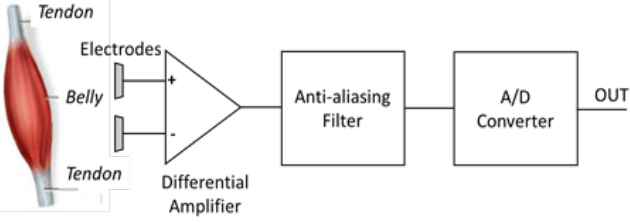
Figure 3. Block diagram of the bio-potential system (HM 121) used for stand-alone wearable surface electromyography (sEMG) signal acquisition.